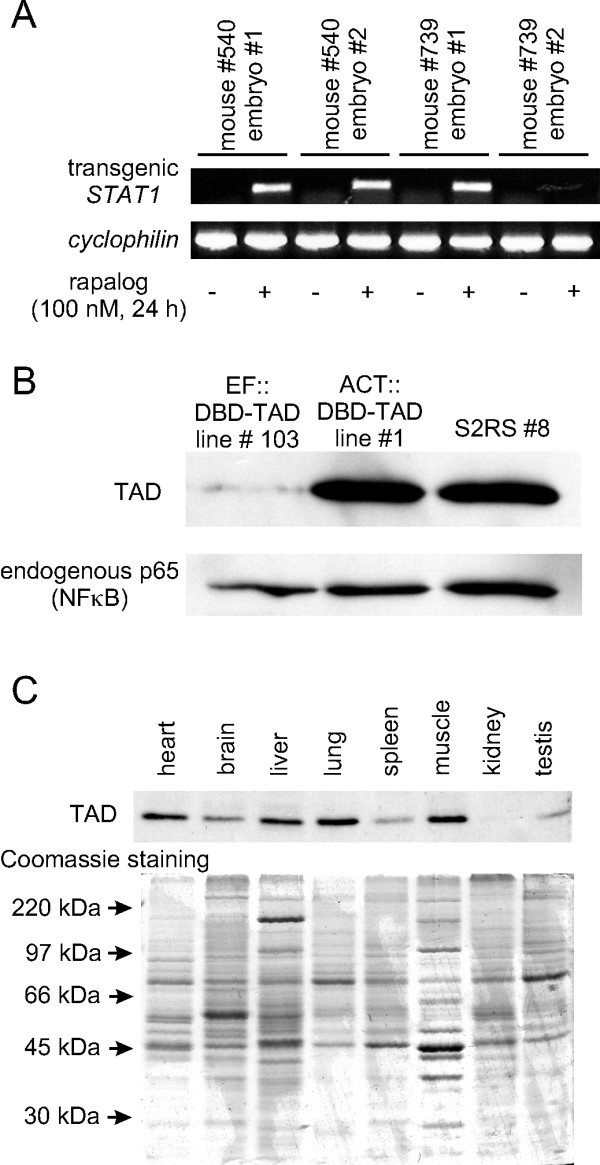
Expression analysis of single-transgenic mice for the ZFHD1::mSTAT1 or the ACT::DBD-TAD construct. Mice transgenic for the target construct ZFHD1::mSTAT1 (line #82) were crossed with non-transgenic mice. PEF were isolated from individual embryos at day 14, transfected with pEF::DBD-TAD, stimulated with 100 nM rapalog for 24 h or left untreated and subjected to RT-PCR analysis for transgenic STAT1 expression; cyclophilin was used as endogenous control (A). PEF were isolated from each embryo separately of transgenic mice (ACT::DBD-TAD, line #1 and EF::DBD-TAD, line #103), lysed and subjected to WB for analyzing expression of TAD compared to MEF line S2RS #8. Loading was controlled with p65/NFκB (B). Protein was isolated from different organs of transgenic mice and WB was performed detecting TAD subunit. As loading control a SDS-PAGE was performed and stained with Coomassie (C).